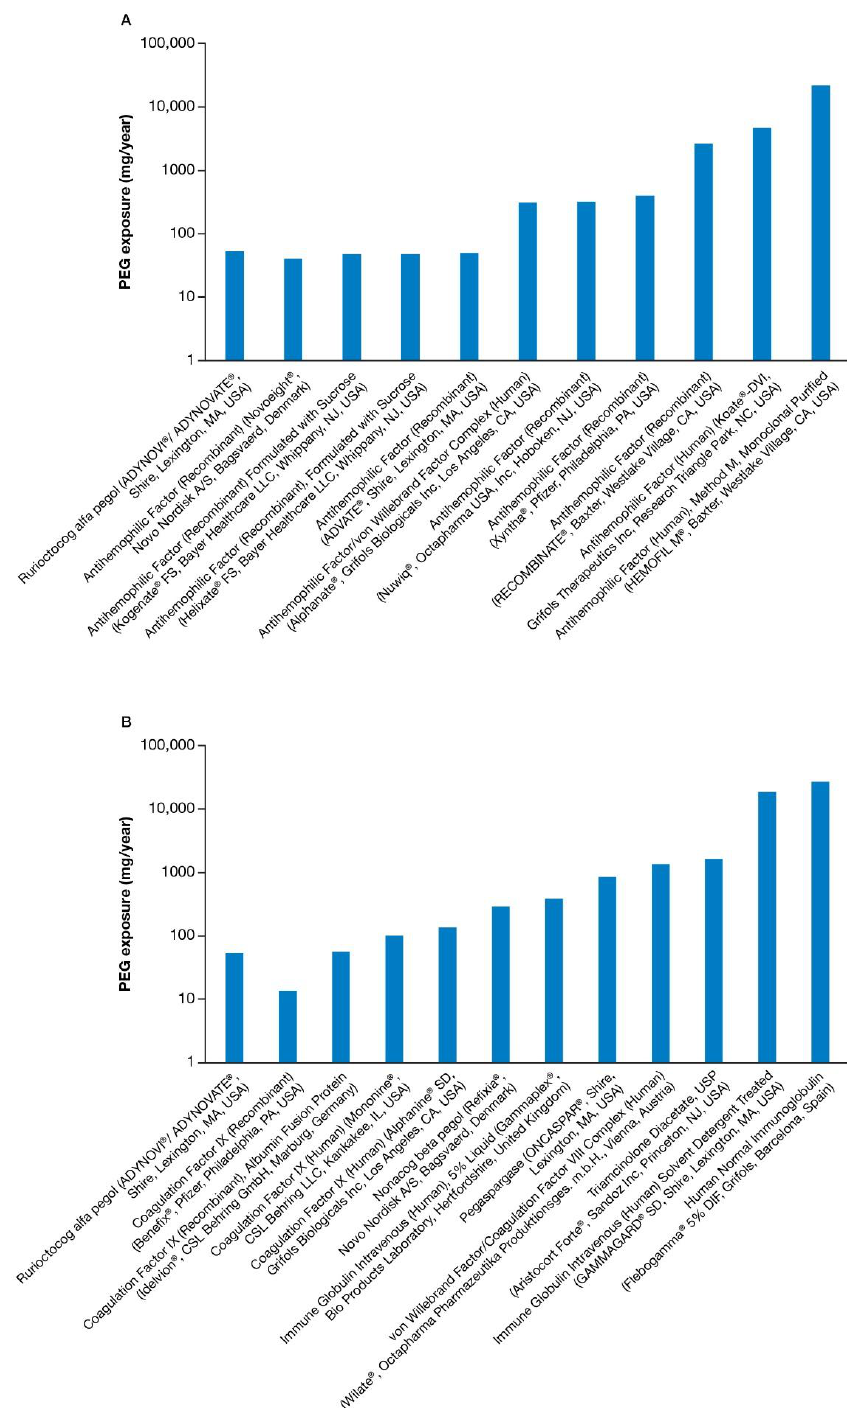
Figure 2. ( A ) Logarithmic plot of PEG exposure per year of rurioctocog alfa pegol versus FVIII prophylaxis in a 50 kg pediatric patient based on the highest dose analyzed. ( B ) Logarithmic plot of PEG exposure per year of rurioctocog alfa pegol versus FIX prophylaxis and other therapies in a 50 kg pediatric patient based on the highest dose analyzed.